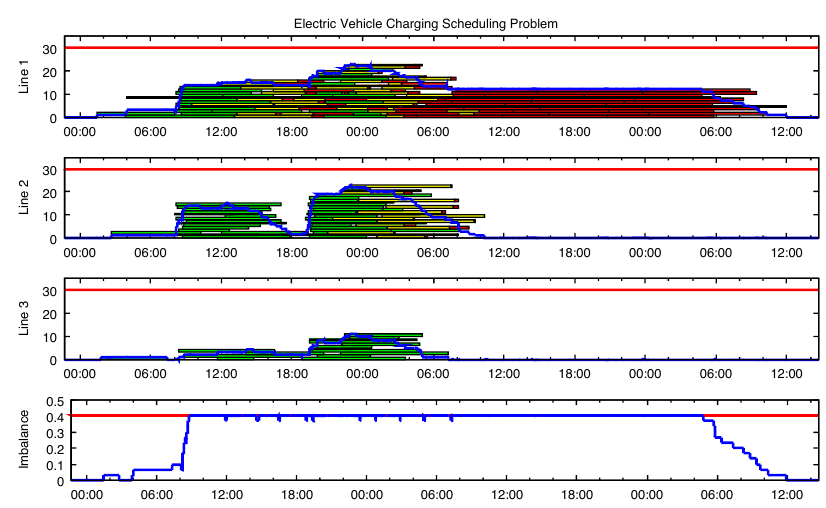
Figure 4. Example of a feasible schedule of a Type 2 instance of scenario 1, with n = 30 and ∆ =